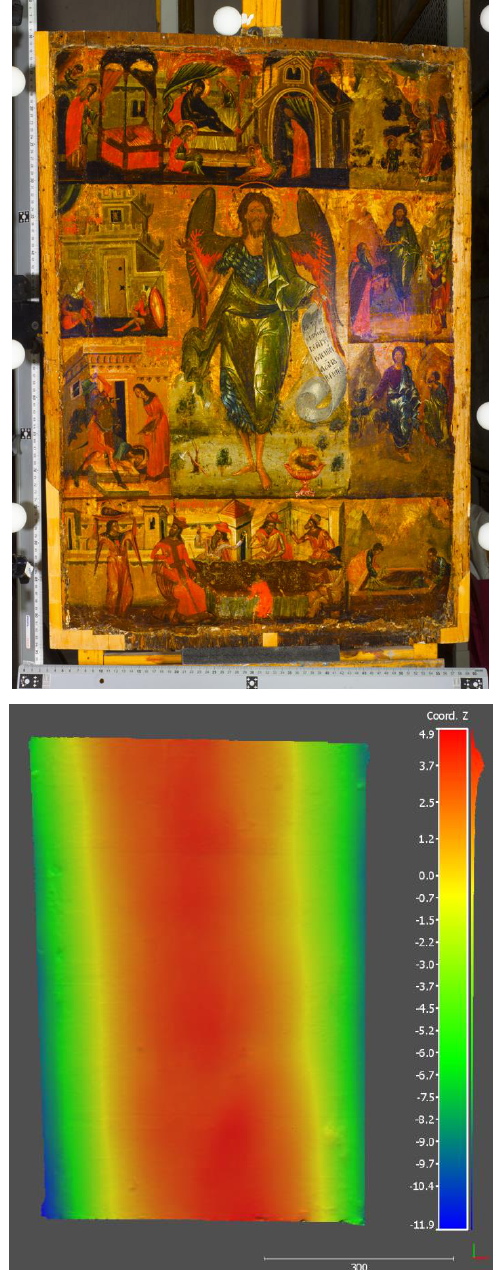
Figure 6. Cretan icon: an image of the artwork with the spheres and bars used during the photogrammetric processing (above). The result of the best fitting plane of 3D coordinates (in mm) obtained with the structured light system